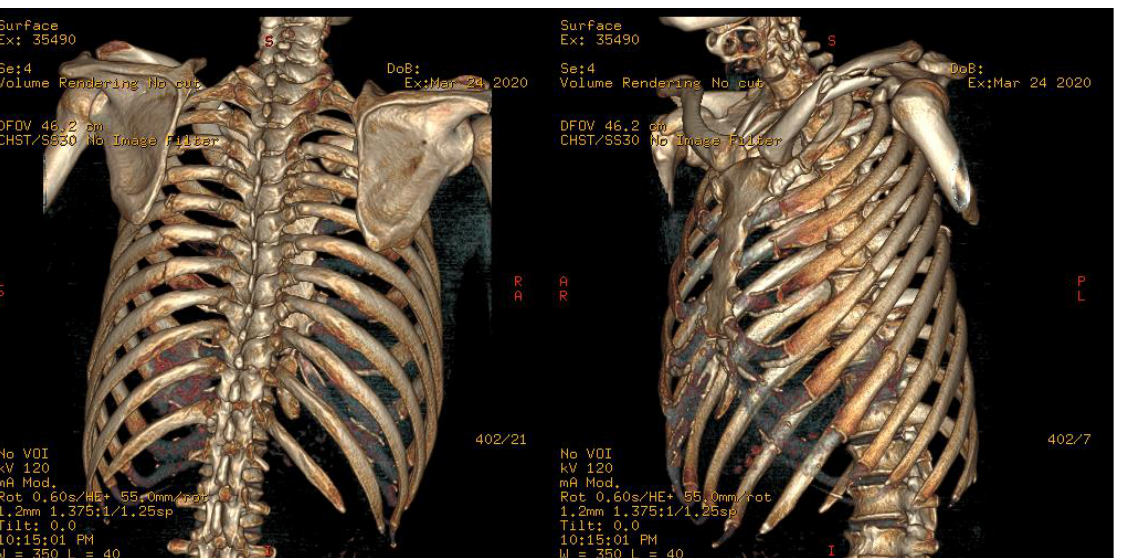
Figure 2. Cross-sectional view of a K-Rod. The four layers of the K-Rod are as follows: an innermost layer of adhesive hydrocolloid dressing, a layer of double-sided foam tape, a piece of five-layered fiberglass casting tape, and an outmost layer of elastic adhesive tape.